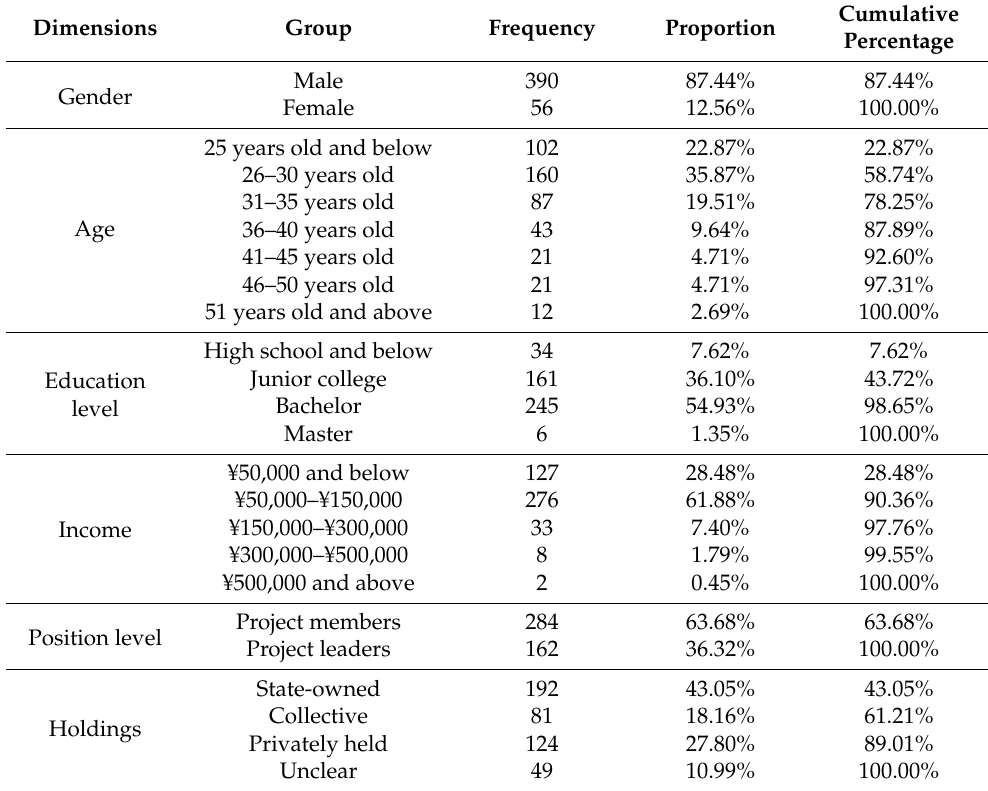
Table 2. Demographic distribution of the sample